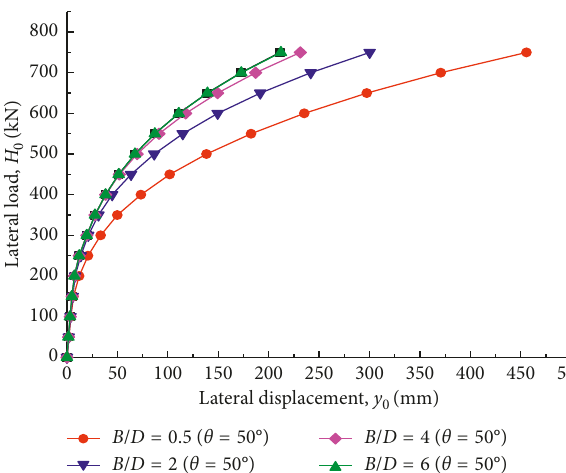
Figure 16: Lateral load-deflection curves for θ normalized distance of pile at pile